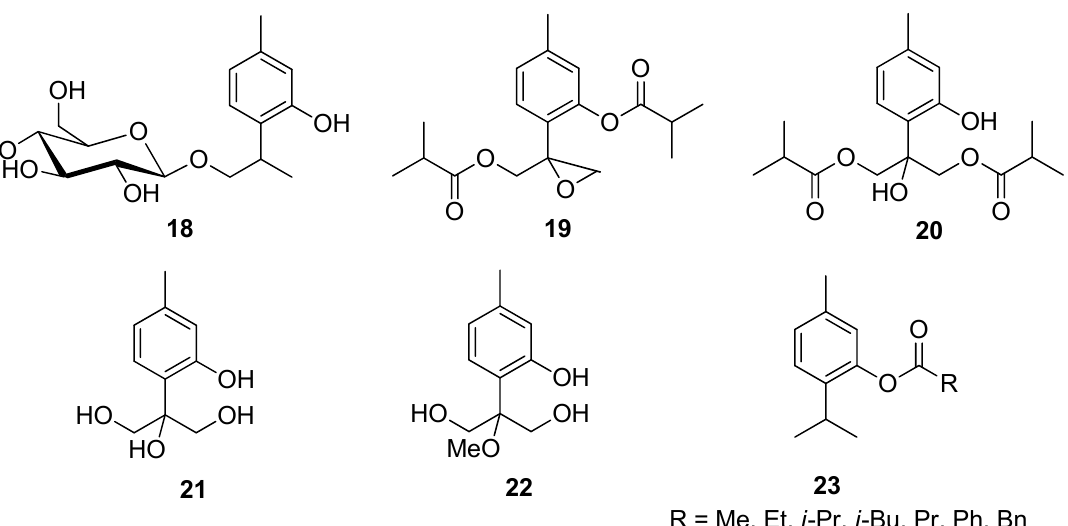
Figure 7. Representative thymol’s derivatives with antimicrobial and antibacterial activities.